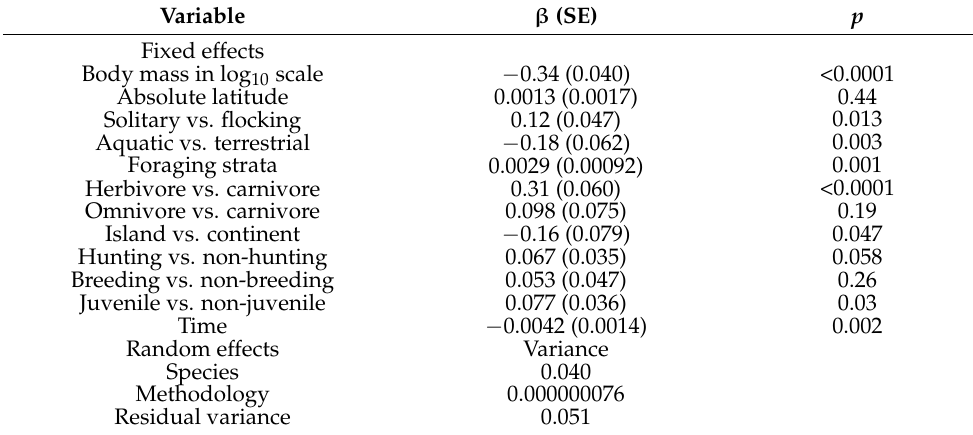
Table 2. Estimates in arc-sine square-root scale from a phylogenetic linear mixed model of various potential correlates of predation rates in birds.